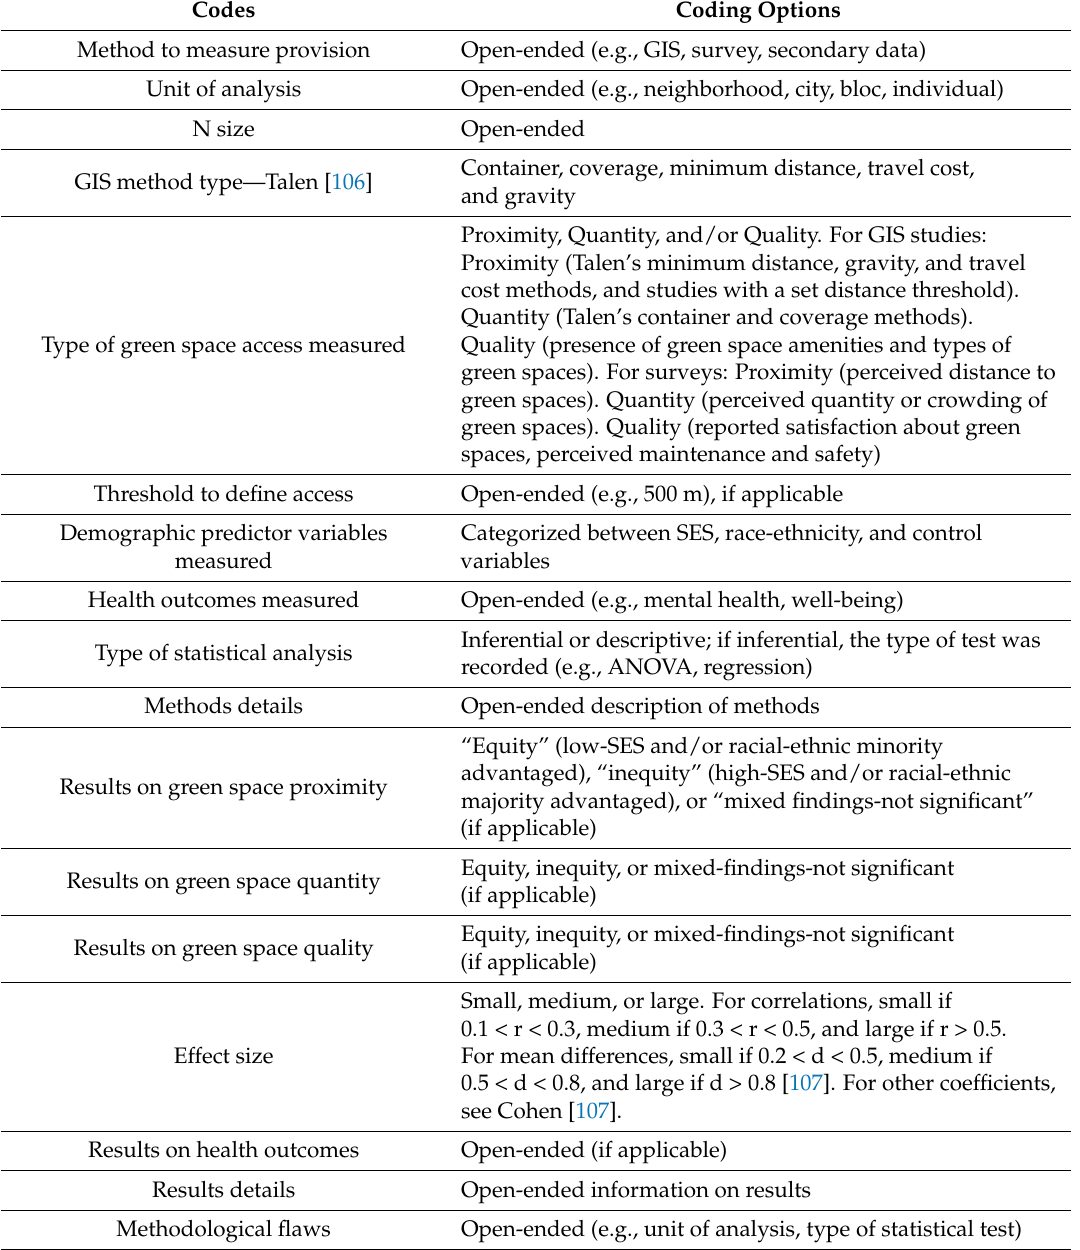
Table 2. Analytical codes to record studies’ methods and results (adapted from Rigolon